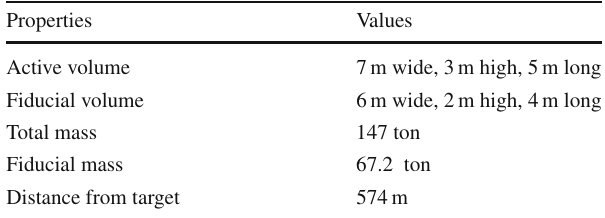
Table 1 LArTPC ND properties used in some of the BSM physics analyses